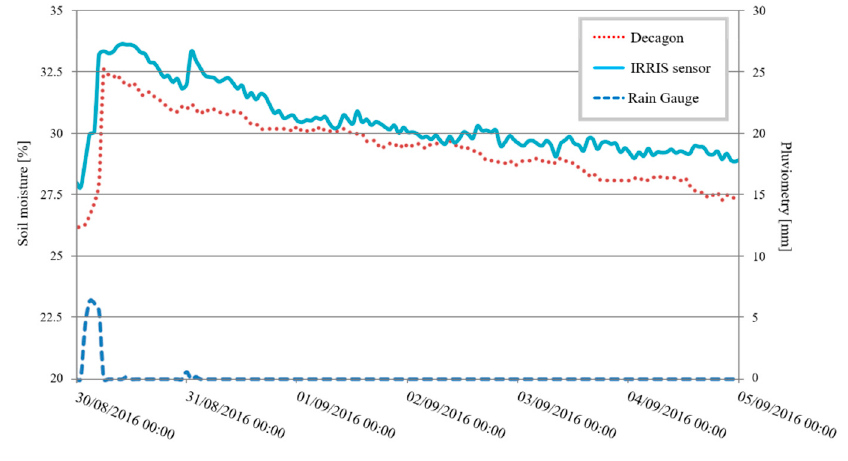
Figure 34. Sensors’ tests in a cornfield.